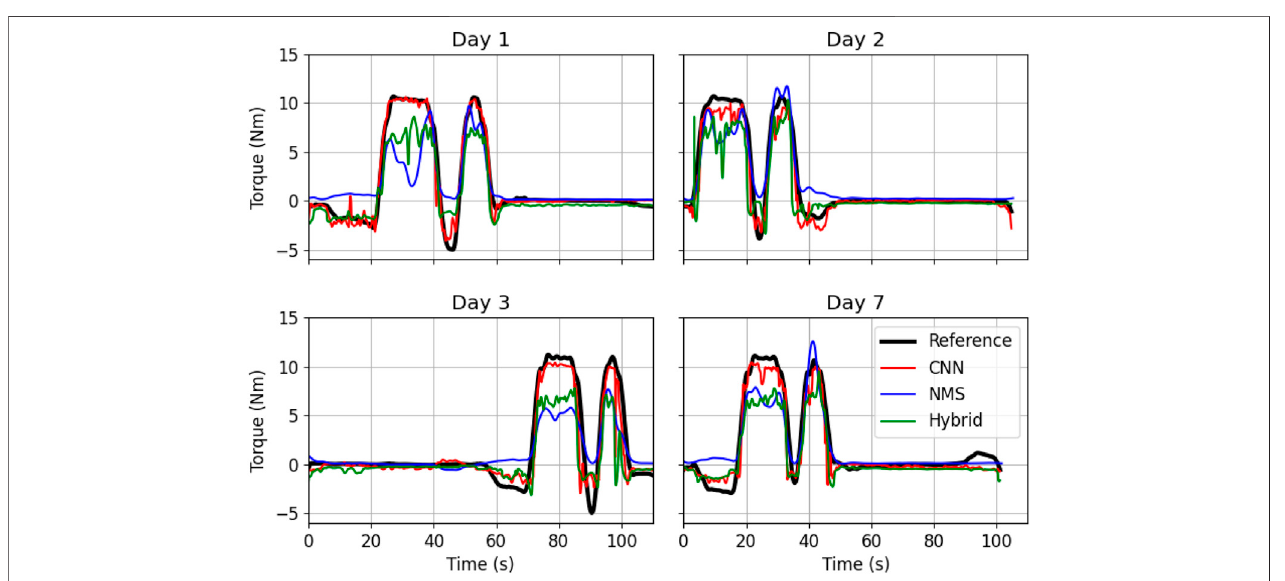
FIGURE2| Exampleoftorqueestimationonthetestsetofonesubjectbythethreedifferentmodelsoverthefourmeasurementdays.Inblackthereferencetorque, in red the predicted torque by the CNN model, in blue by the NMS model and in green by the Hybrid model.